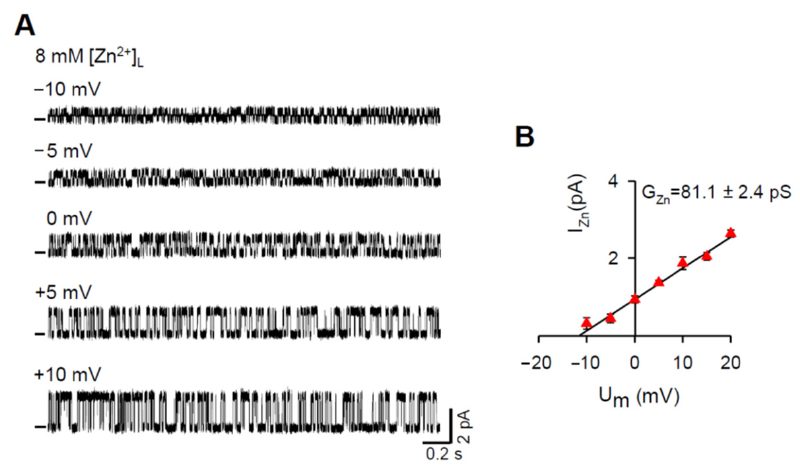
Figure 1. The RYR2 channel is permeable to Zn 2+ . ( A ) Representative RYR2 currents (digitally filtered at 250–400 Hz), shown as upward deflections from the marked zero-current level, in the presence of 8 mM [Zn 2+ ] L when Zn 2+ was only the charge carrier. Current recordings were conducted at − 10, − 5, 0, +5, +10 mV and are from the same channel. RYR2 channels were activated by 6–7 mM caffeine in the presence of 90 nM free [Ca 2+ ] C . ( B ) Current-voltage relationship of the RYR2 channel was well-fitted by a straight line with the G Zn value of 81.1 ± 2.4 pS. Data shown are average ± SEM of 5–7 experiments and error bars are shown only when SEM is larger than symbol